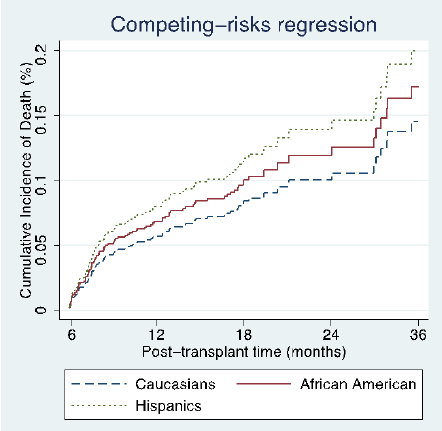
Figure 2. Cumulative incidence of death post-transplant (with re-transplant as competing risk) by race /